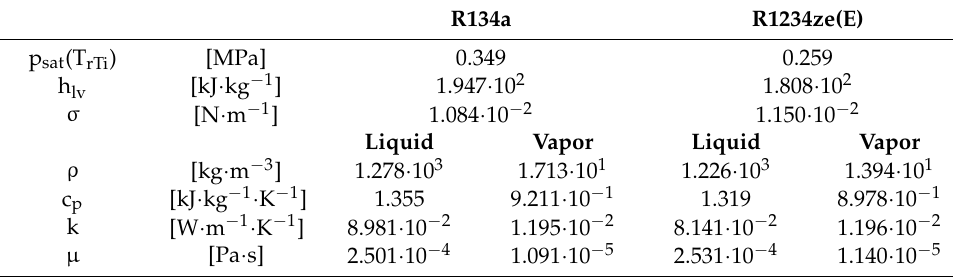
Table 3. Comparison between the thermal properties of R134a (reference fluid) and R1234ze(E) during flow boiling, operating temperature T rTi = 5 ◦